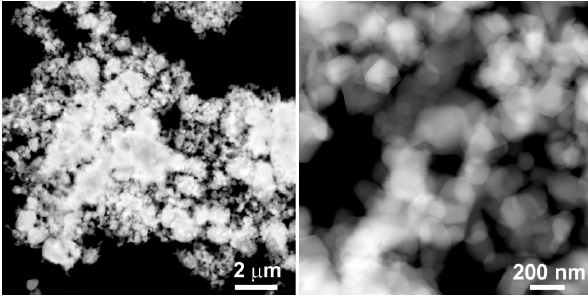
Figure 1. High angle annular dark-field scanning transmission electron microscopy (HAADF-STEM) images of the pristine Li 1.17 Ni 0.17 Mn 0.5 Co 0.17 O 2 sample demonstrating highly agglomerated crystallites.